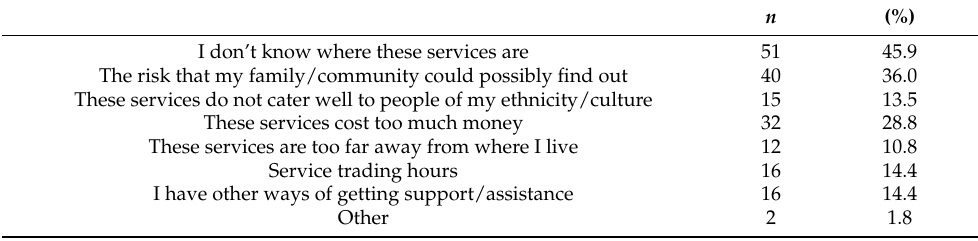
Table 7. Participants perceptions of potential barriers to SRH help-seeking.